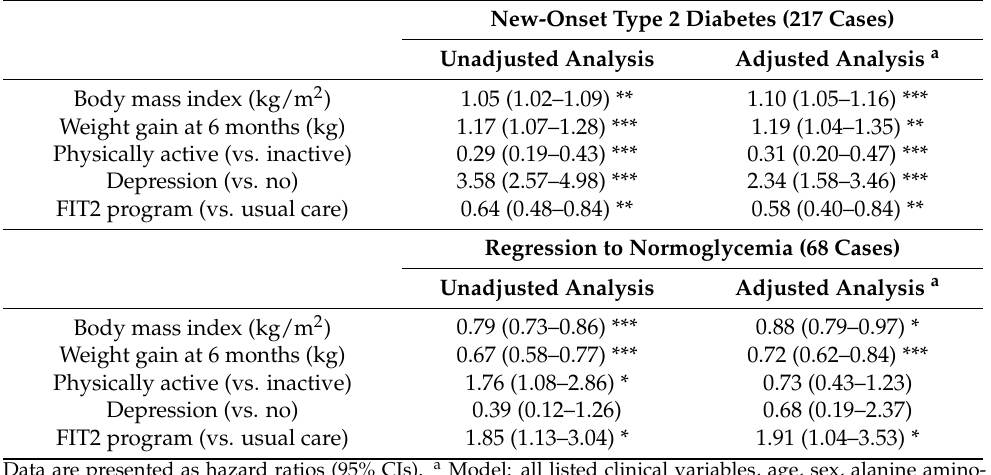
Figure 1. Long-term effect of the FIT2 program on type 2 diabetes risks in the intention-to-treat analysis. Table 1. Factors for long-term glycemic outcomes among prediabetic smokers in the intention-to-treat analysis ( n =